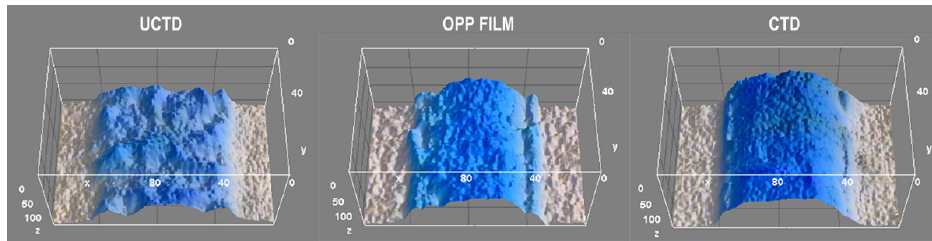
Figure 10. 3D topographic view of line 170 μ m width at three different printing substrates.